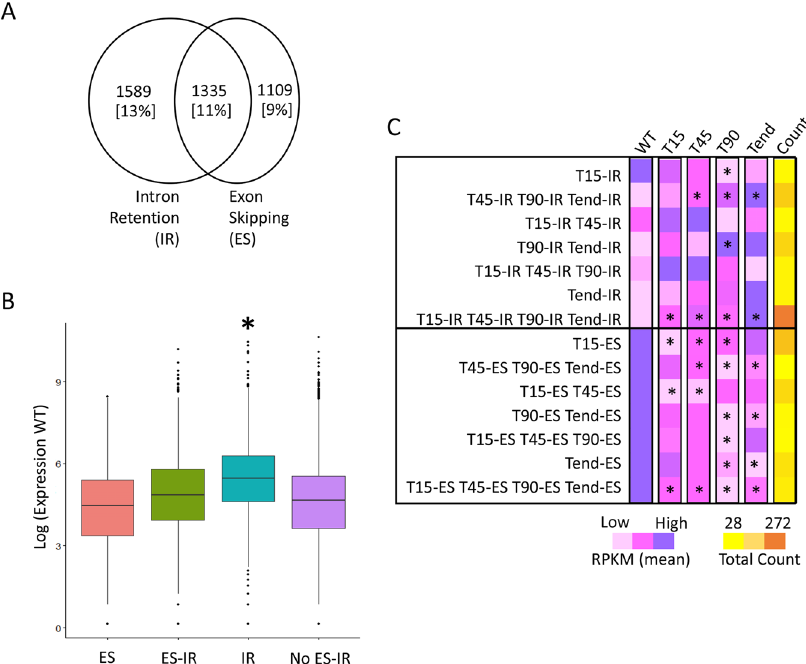
Figure 4. Alternative splicing in P. tricornutum . The Venn diagram depicts ( A ) the number of genes predicted to undergo alternative splicing in the context of intron retention (IR) and exon-skipping (ES). Numbers and percentages (in square brackets) in the Venn diagram reflect the absolute number of genes and the relative percentage out of the total Phatr3 genes. ( B ) The box-plot represents the differences in expression of genes corresponding to different functional categories, represented on x-axis. Y-axis represents the expression of the genes in the wild-type (WT) (Biosample accession: SAMN06350643), scaled to log scale. ( C ) The heat- map compares the average expression of genes exhibiting intron-retention/exon-skipping (IR/ES) at different time-points (T15, T45, T90 and Tend) in Nfree culture conditions. For example, T15-IR row compares the average expression of all the genes exhibiting intron retention (IR) are time T15 across all the time-points. The last column represents the heat-map based on the number of genes in each category indicated on left Y-axis. * Indicates the level of significance as being significant (P-value < 0.05, two sample t-test with unequal variance) when the average expression of a particular sub-set is compared to the WT. Nfree in the figure denotes the culture condition with no source of nitrogen, WT denotes wild type or normal condition, T15 denotes RNAseq performed on cells sampled after 15 minutes of the culture, Similarly, T45, T90 and Tend denotes RNAseq libraries were prepared upon sampling the cells after 45 minutes, 90 minutes and 18 hours of culture,